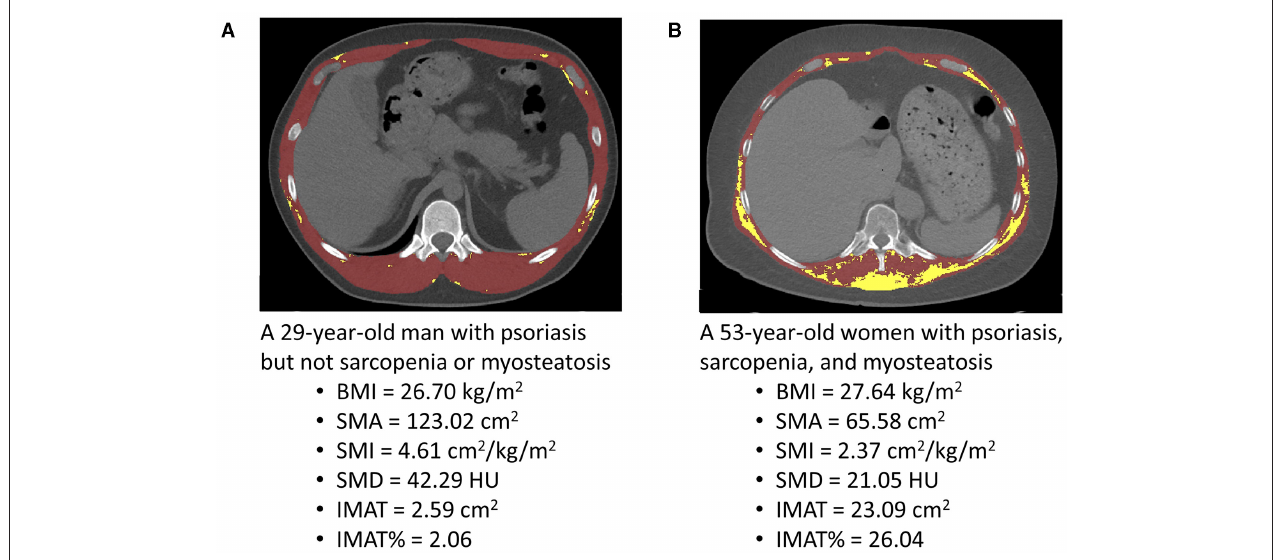
FIGURE 1 | Typical segmented computed tomography (CT) images at the 12th thoracic vertebra level used for the quantification of the skeletal muscle area (SMA), skeletal muscle radiodensity (SMD), and intermuscular adiposity tissue (IMAT) in a young man with psoriasis (A) and a middle-aged woman with psoriasis (B) . BMI, body mass index; HU, Hounsfield unit; SMI, skeletal muscle index; IMAT%, percentage of